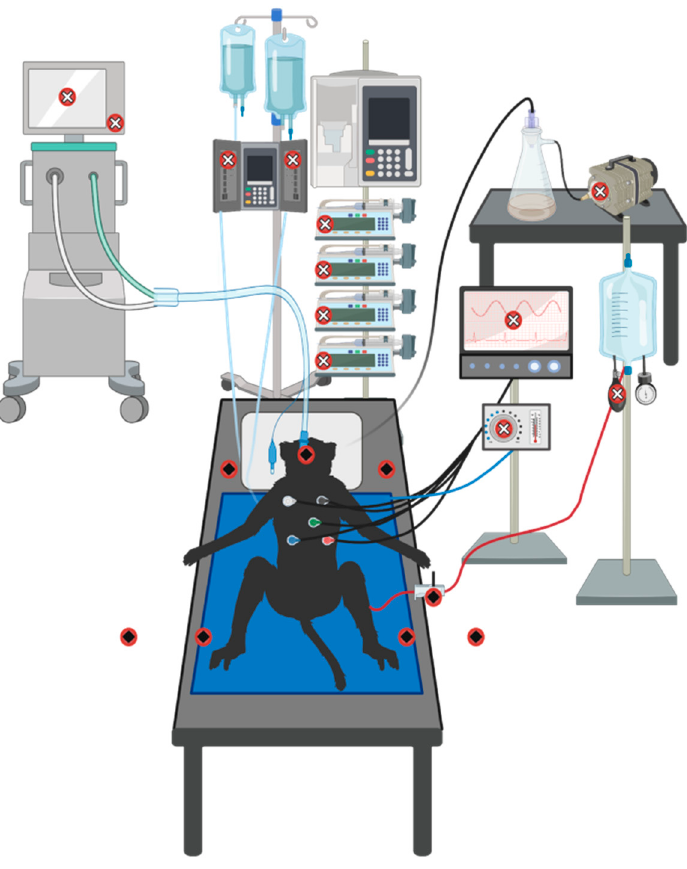
Figure 4. Environmental surface sampling. Swabbing occurred immediately post-mortem for both studies following NHP multi-system organ failure for 5–10 s per surface. The patient area ( ) included the endotracheal tube (ETT), ART-line and CVP transducers, the right and left sides of the head of the bed, the right and left sides of the bed in line with the NHP, and the floor on either side of the bed. The device area ( ) included the Avea Ventilator dial and entirety of screen, the Intellivue MX800 Patient Monitor screen, the Alaris SE Volumetric Pump, four Alaris CC Syringe Pumps, the pressure bulbs to maintain adequate pressure for ART-lines, the suction pump, and the HotDog Veterinary Patient Warming System on/off button (not shown).